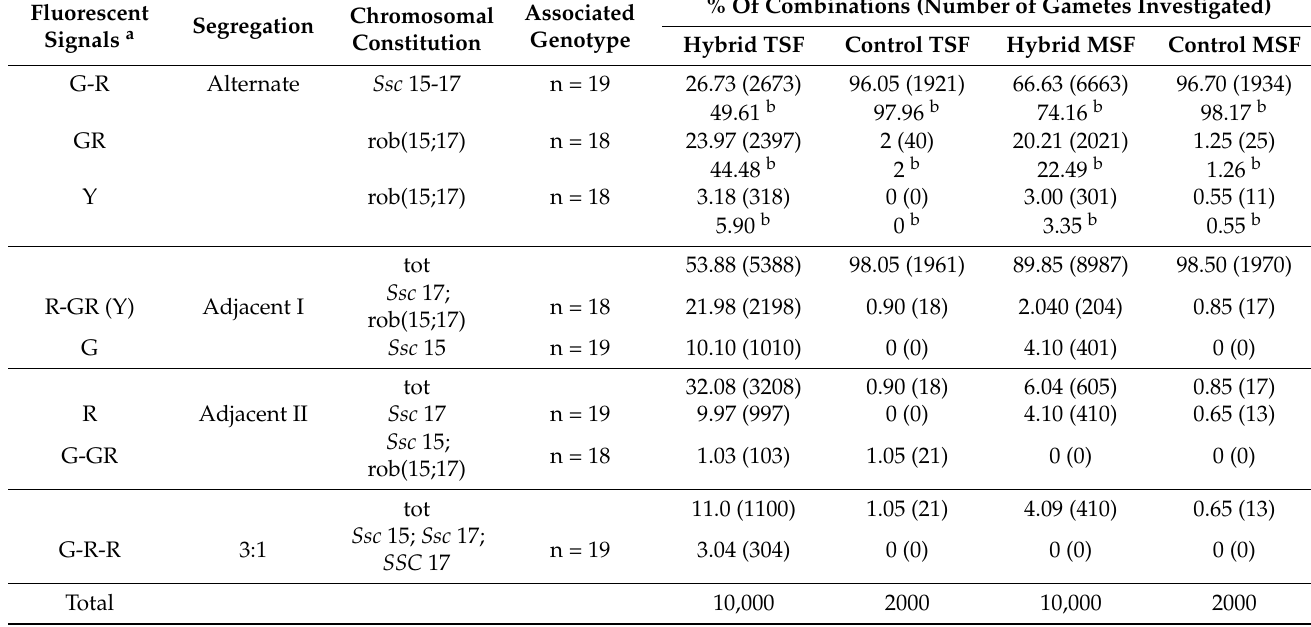
a Fluorescence signals detected on decondensed sperm nuclei: G = green; R = red; Y = yellow. b Percentage refers to alternate segregation total count sperms.